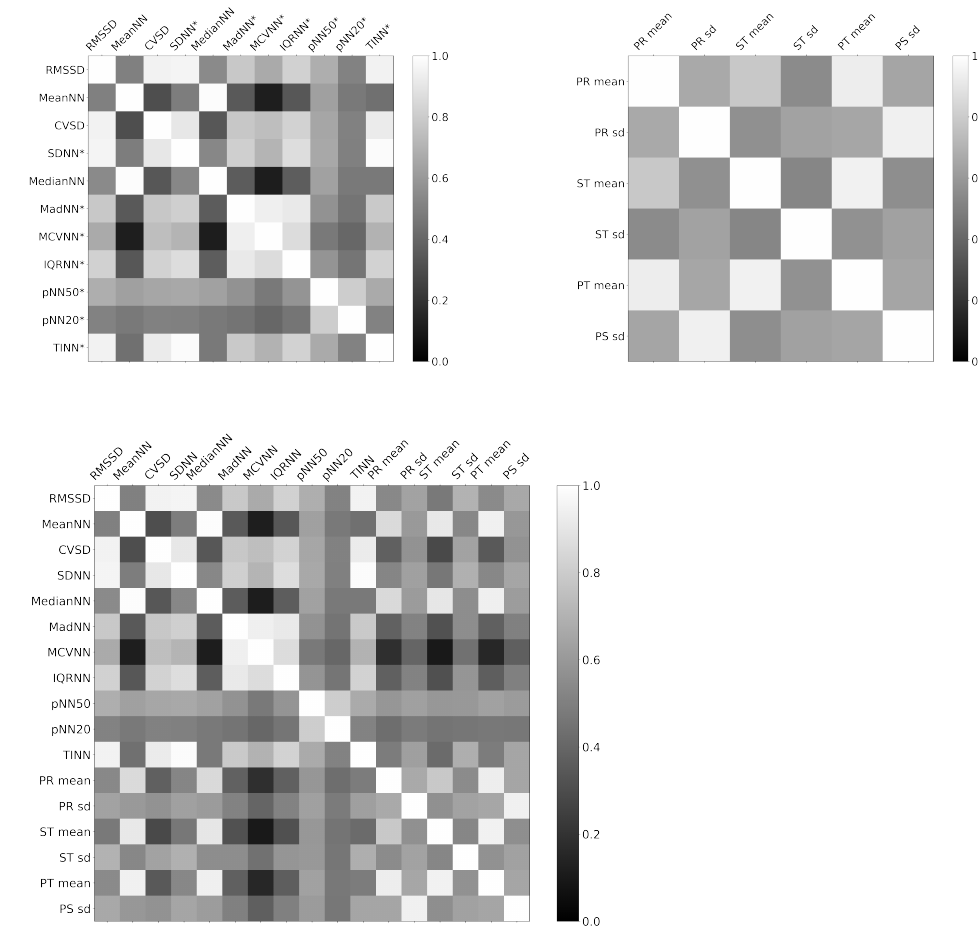
Figure 2. Correlation matrices for features included in the TFM and NFM. The top left matrix shows Pearson correlation coefficients between R-peak-derived traditional features; the features with an asterisk (*) are included in both the TFM and NFM, and those without are only included in the TFM. The top right matrix shows the correlation coefficients between the novel small-peak-derived features that are only included in the NFM. The bottom matrix shows all features in both